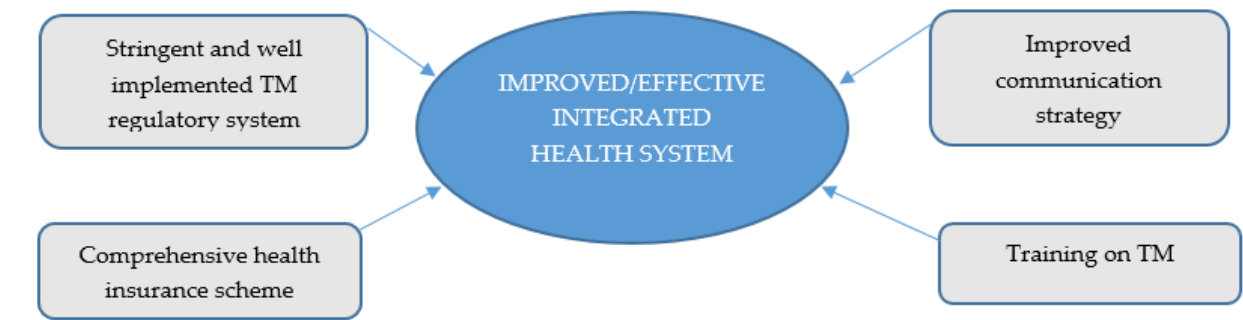
Figure 3. Participants’ recommendations to enhance TM integration into the Ghanaian health system.